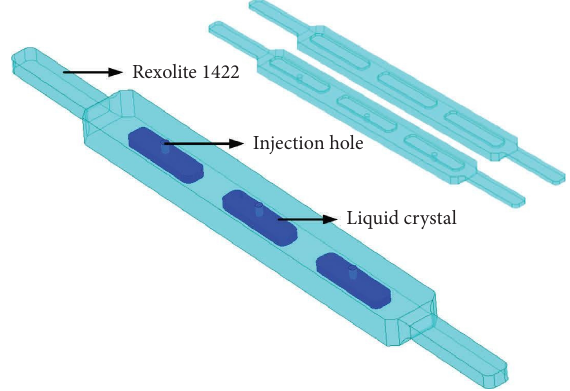
Figure 6: Te Rexolite dielectric